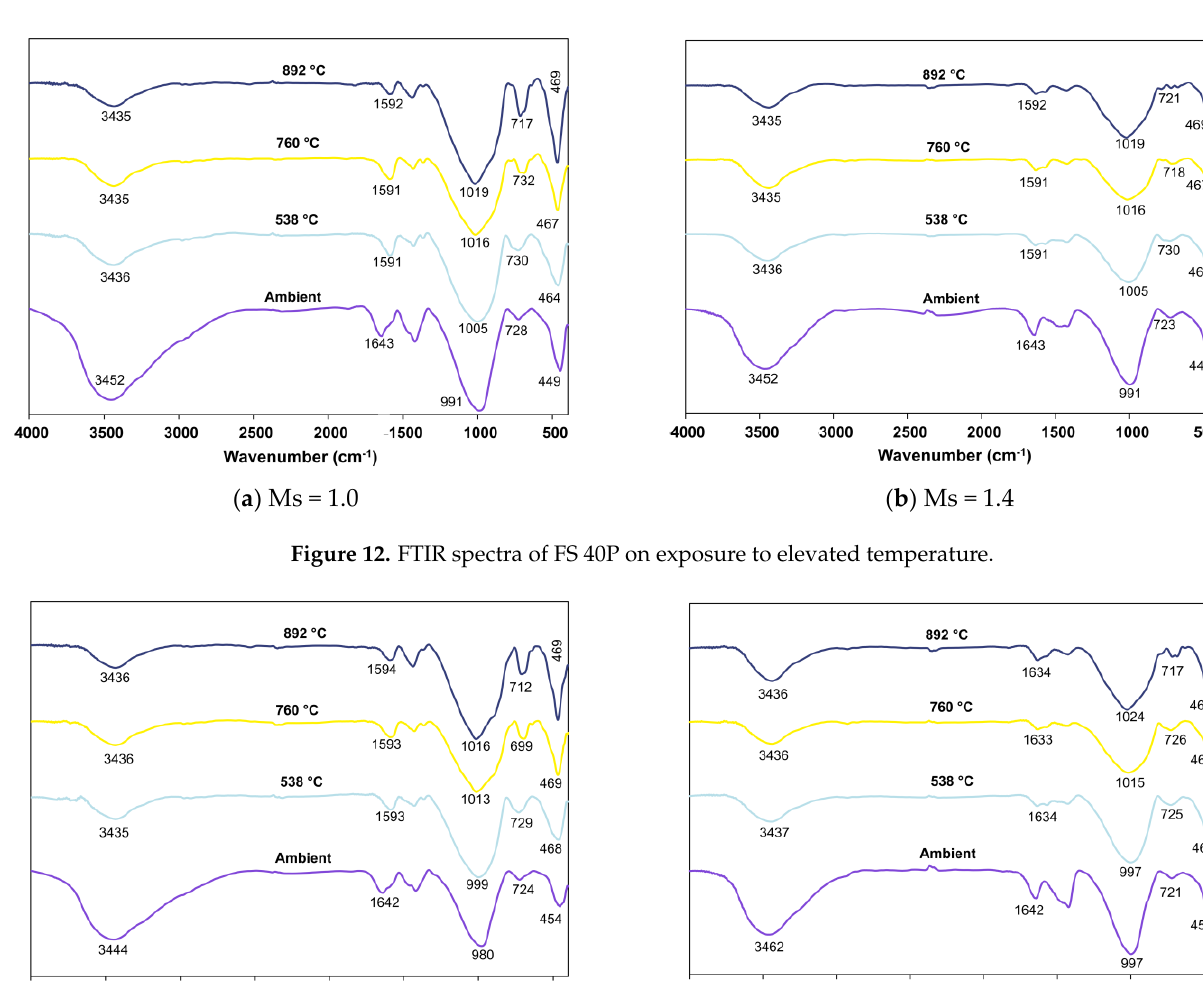
Figure 11. FTIR spectra of FS 30P on exposure to elevated temperature.